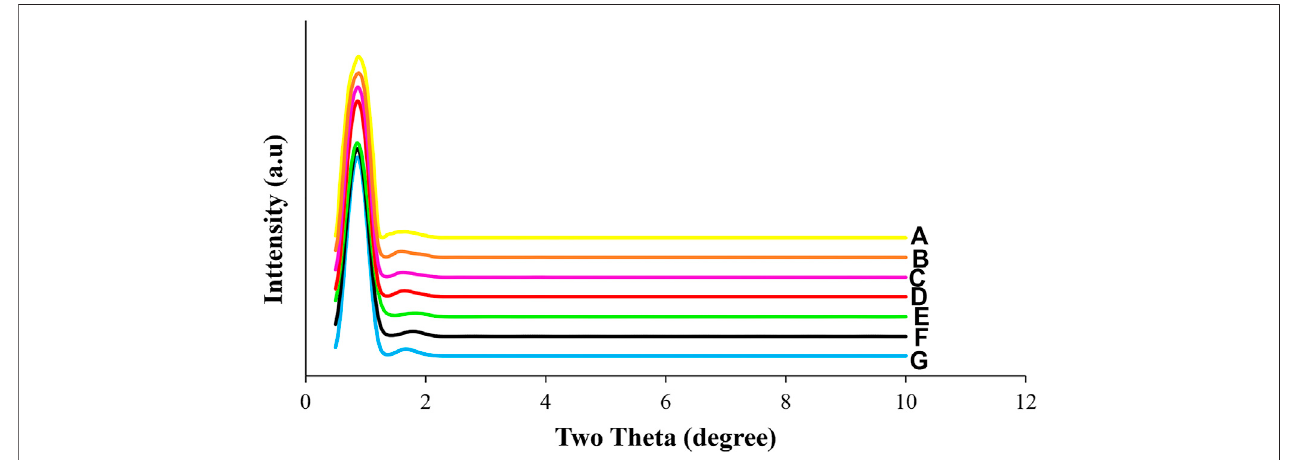
FIGURE 3 | Low angle XRD patterns of OCP f -supported NiMo catalysts (A) 5.0wt%Ni26wt%Mo/OCP f (B) 5.0wt%Ni19wt%Mo/OCP f (C) 5.0wt%Ni13wt%Mo/ OCP